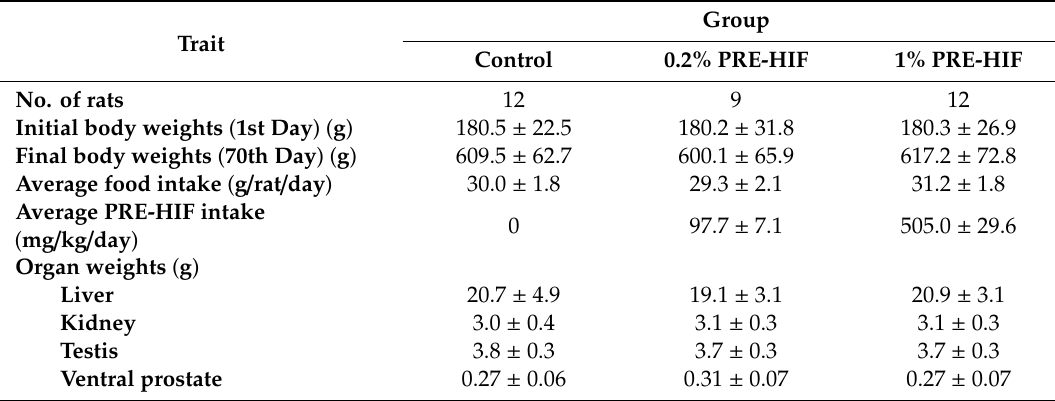
Table 1. Body weights, organ weights, and PRE-HIF intake of TRAP rats treated with PRE-HIF. Trait